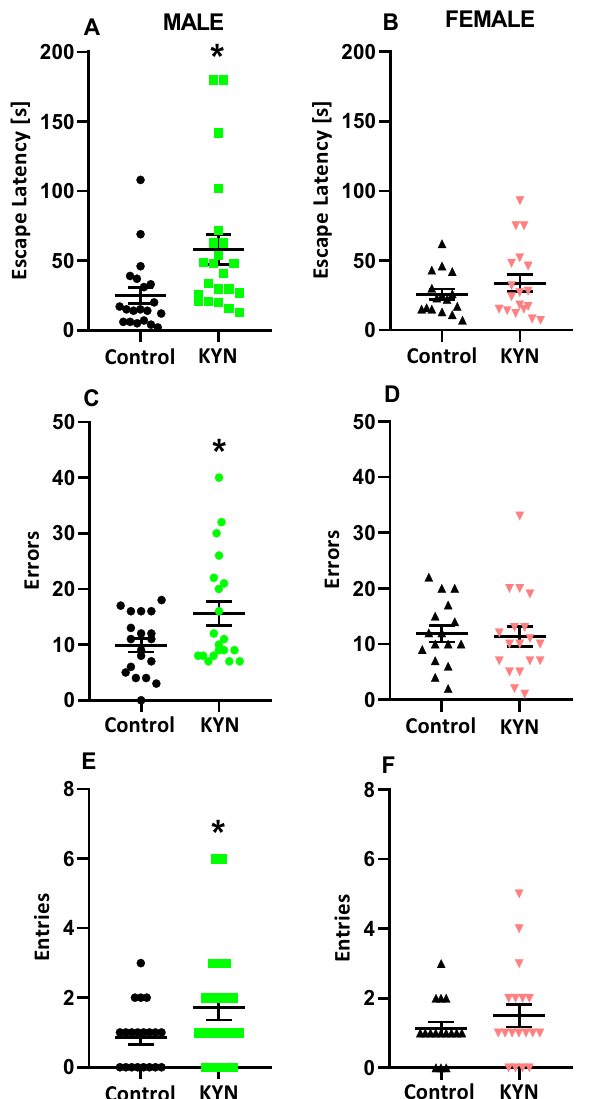
Figure 3. Effect of kynurenine administration during maternal feeding on reversal learning of adult rats. Escape latency ( A , B ), errors committed ( C , D ), entries into the previous escape location ( E , F ). Data are presented as a mean ± SEM, number of subject = 9–11 per group, *P < 0.05 vs respective Control, Student t -test. KYN